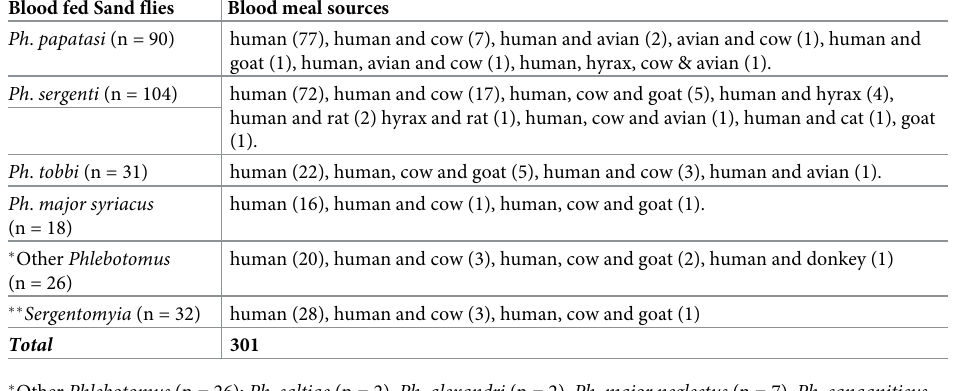
Table 3. The animal and human sources of blood meals imbibed by female sand flies determined by cyt b PCR analysis. Blood fed Sand flies Blood meal